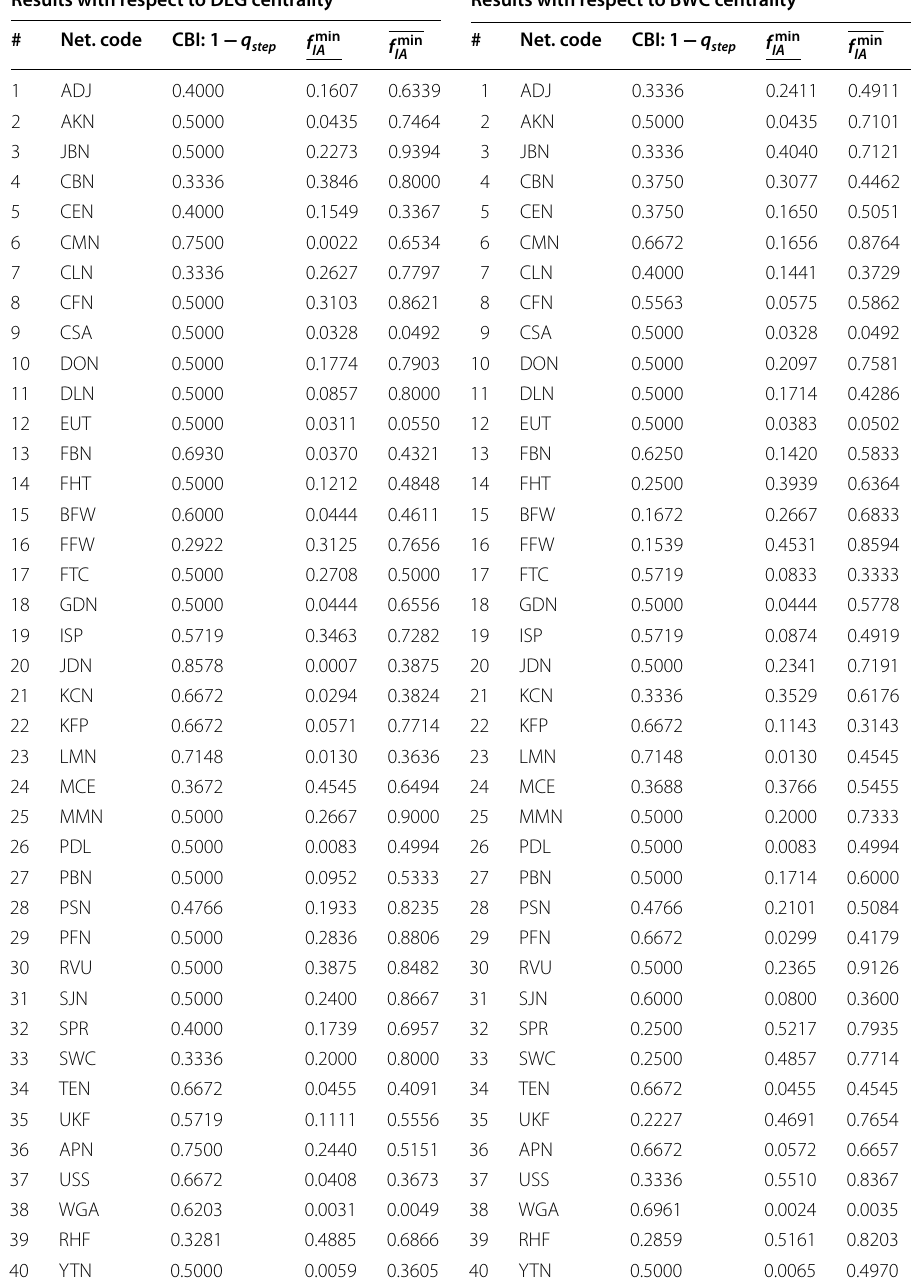
Table 3 Results obtained for the Real‑World Networks Results with respect to DEG centrality Results with respect to BWC